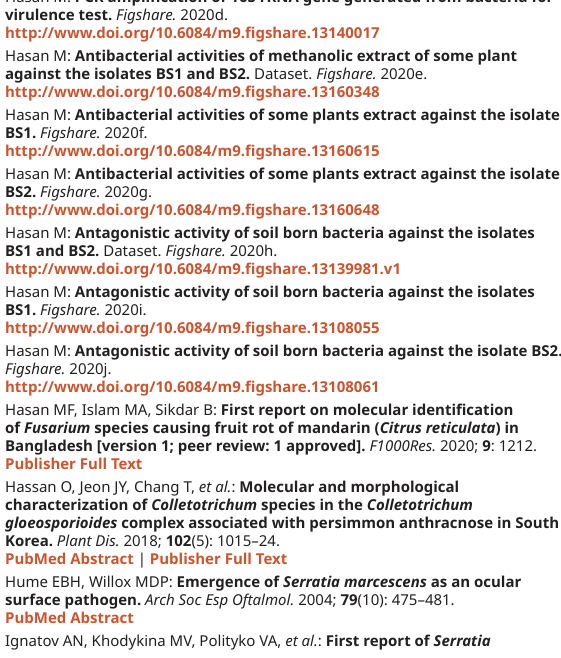
Figshare: Antibacterial activities of some plants extract against the isolate BS2, https://doi.org/10.6084/m9.figshare.13160648 (Hasan, 2020g).